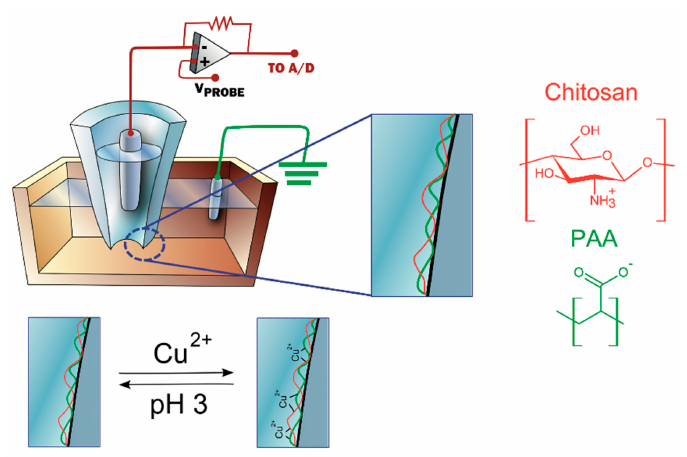
Figure 9. Schematics showing the electrochemical configuration (top left) and the reversible binding of copper ions on the chitosan/PAA-modified nanopipette. (Reprinted with permission from [101]. Copyright (2018) American Chemical